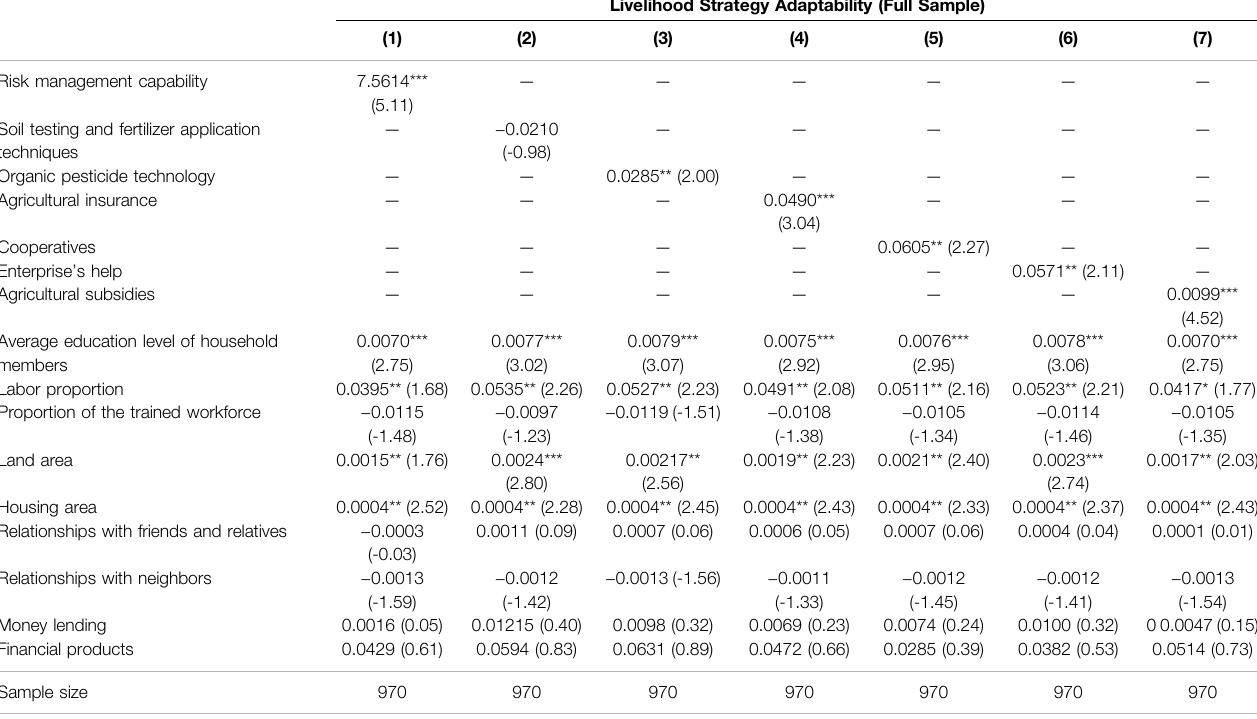
TABLE 4 | Full sample regression